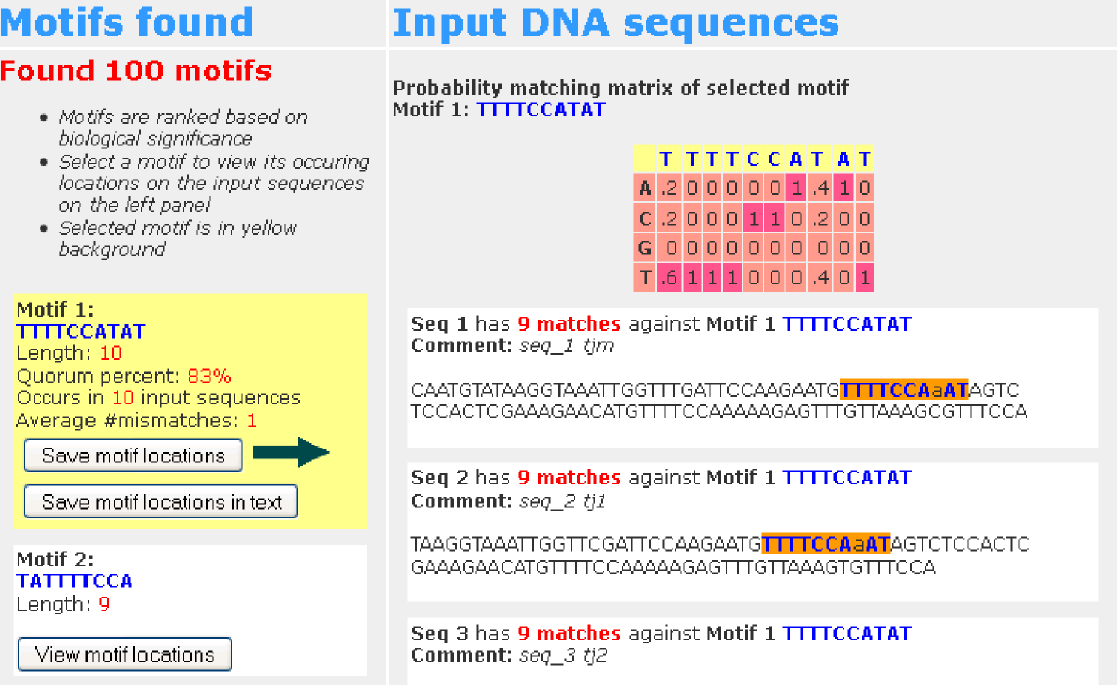
Figure 4. Result available - DNA sequences. An example of the results page when the submission is processed. The locations of the second motif are marked on the DNA input sequences.